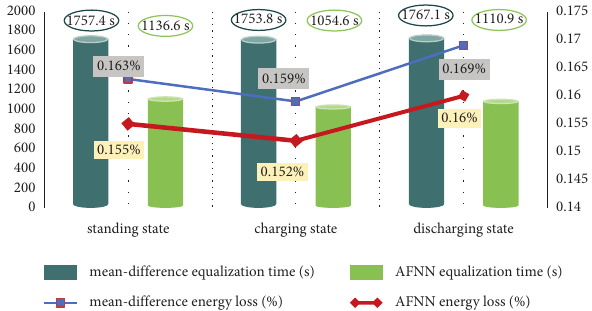
Figure 19: Equalization results based on mean-difference algo- rithm and AFNN algorithm in the three